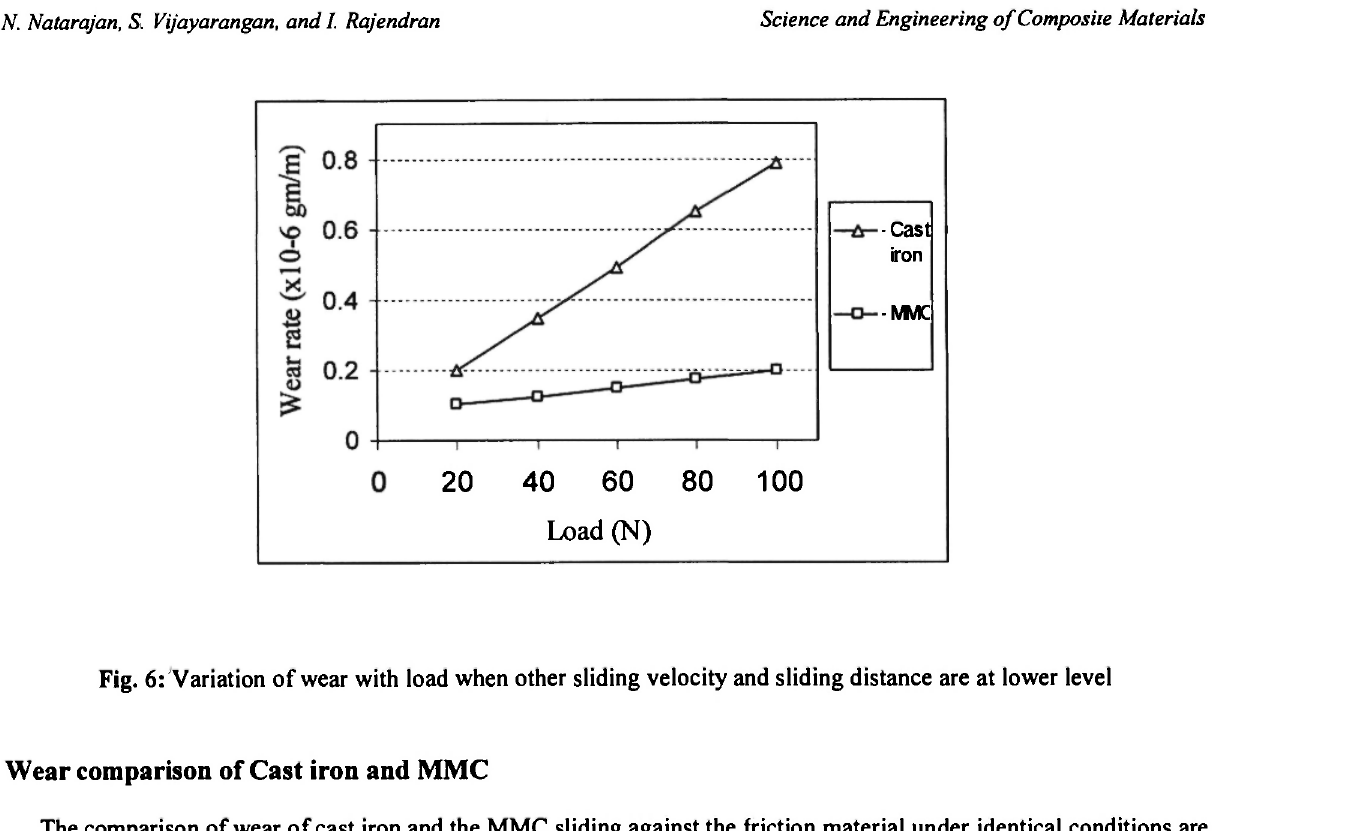
Fig. 6: Variation of wear with load when other sliding velocity and sliding distance are at lower level